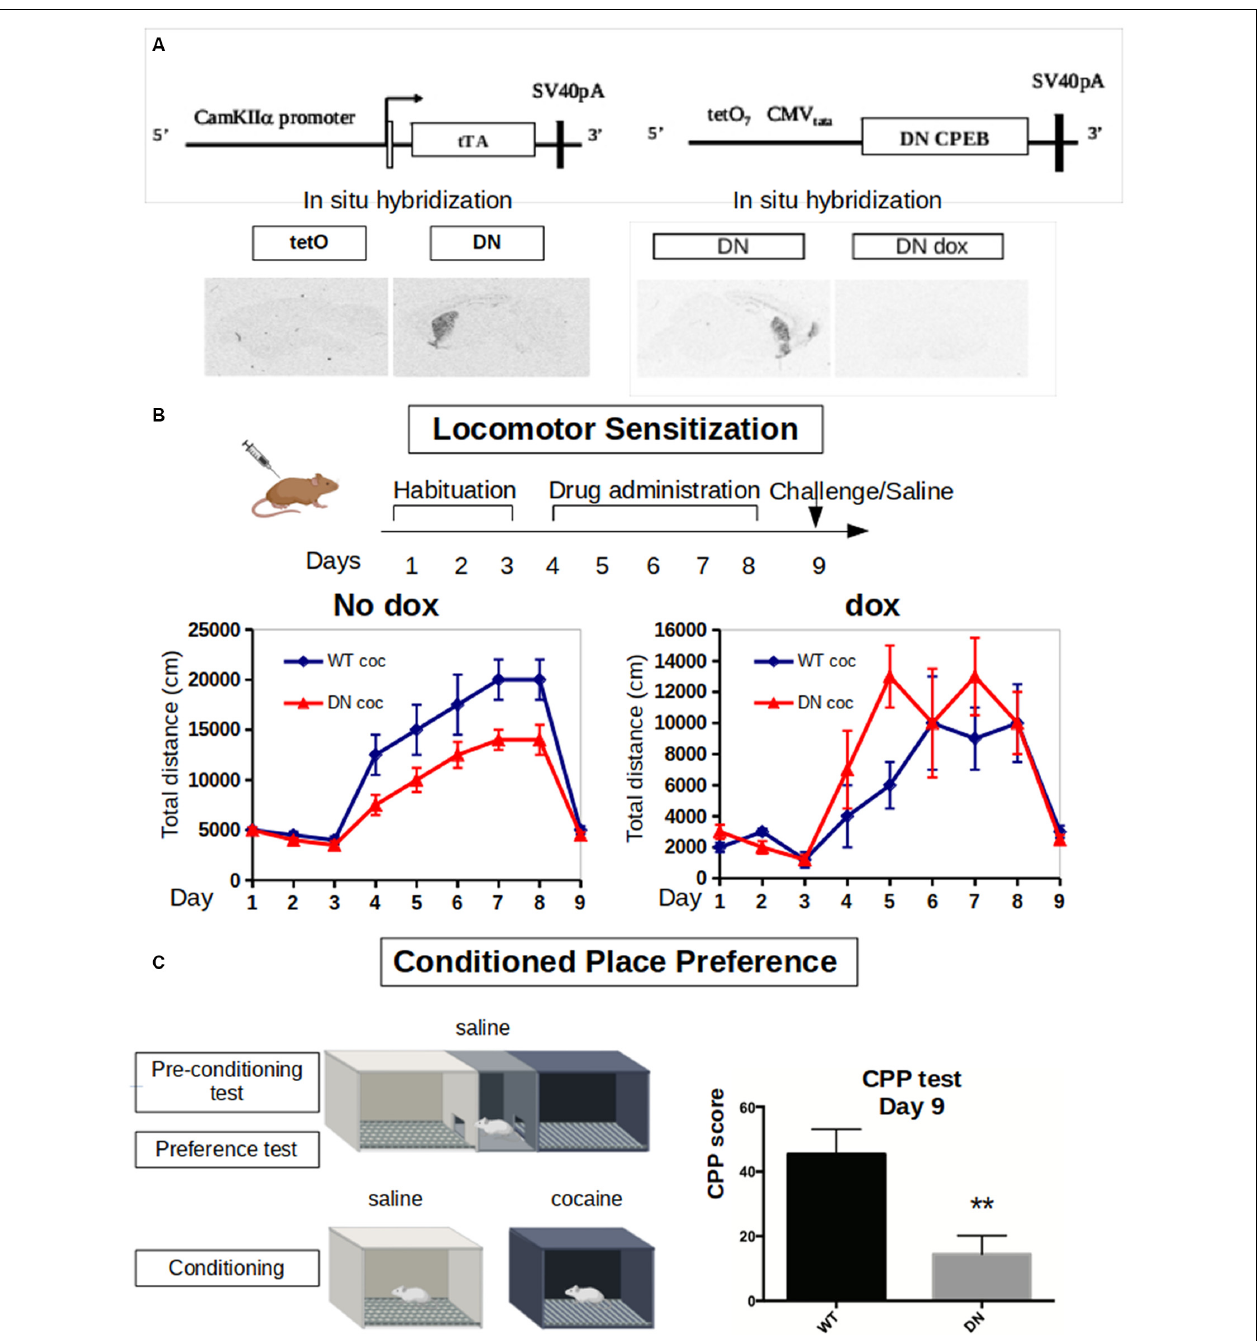
FIGURE 3 | Dominant-negative DN-CPEB mice exhibit a deficit in both locomotor sensitization and Conditioned Place Preference (CPP) after cocaine treatment. (A) Schematic of the tetO and tTA transgenes of the DN-CPEB mice. In situ hybridization shows the expression of the transgene in the absence of doxycycline. (B) DN-CPEB mice were tested in a locomotor sensitization behavioral task. After 3 days of habituation in which both DN-CPEB and wild type (WT) mice, 10 per group, were shown to have similar baseline locomotion, mice were injected with cocaine 30 mg/kg for five consecutive days and their movement was recorded. DN-CPEB mice showed a considerable decrease in motor sensitization when compared to WT mice ( F = 18.137; ANOVA, p < 0.0001). As control-CPEB mice were exposed to doxycycline (200 mg/kg) to prevent the expression of the TetO transgene. After 3 days of habituation in which both DN-CPEB dox and WT mice, 10 per group, were shown to have similar baseline locomotion, mice were injected with cocaine 30 mg/kg for five consecutive days and their movement was recorded. DN-CPEBdox mice showed no decrease in motor sensitization when compared to WT mice. (C) CPP was performed with the DN-CPEB and WT mice. After 4 days of cocaine pairing for both the DN-CPEB and WT animals, on the test day, the DN-CPEB mice spent less time in the cocaine-paired box compared to the WT mice (two-tailed t -test, p = 0.004), suggesting a potential role of CPEB1 and 3 in the rewarding properties of cocaine. ** p < 0.01.